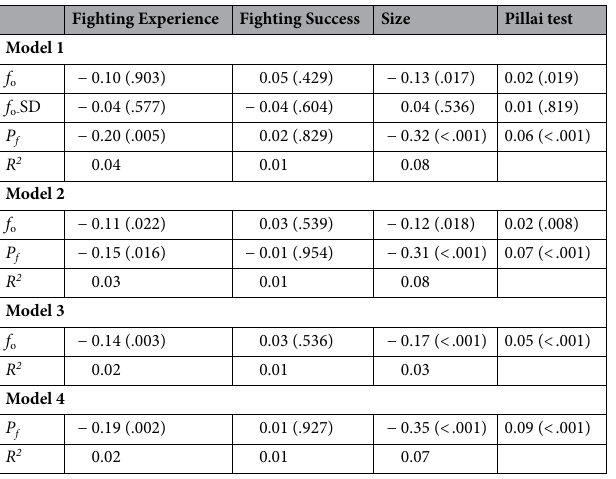
Table 4. Results of a multi-variate regression model. Results are reported as effect size (p-value). Effect sizes are beta-weights, except for Pillai’s trace test statistics. f o = fundamental frequency; f o -SD = Variability in fundamental frequency; P f = formant